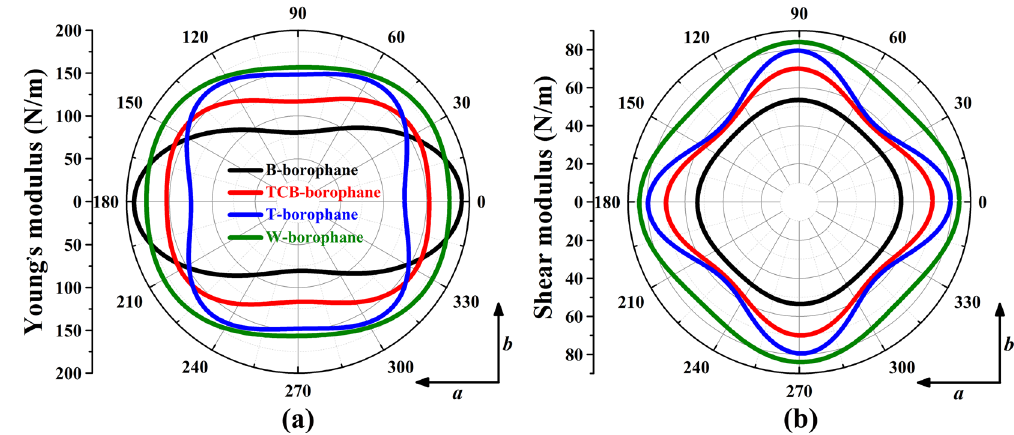
Figure 11. Polar diagrams for Young’s modulus and shear modulus of B-, TCB-, T- and W-borophane. The angle is measured relative to the a direction. Isotropic (anisotropic) behavior is associated to a circular (noncircular)